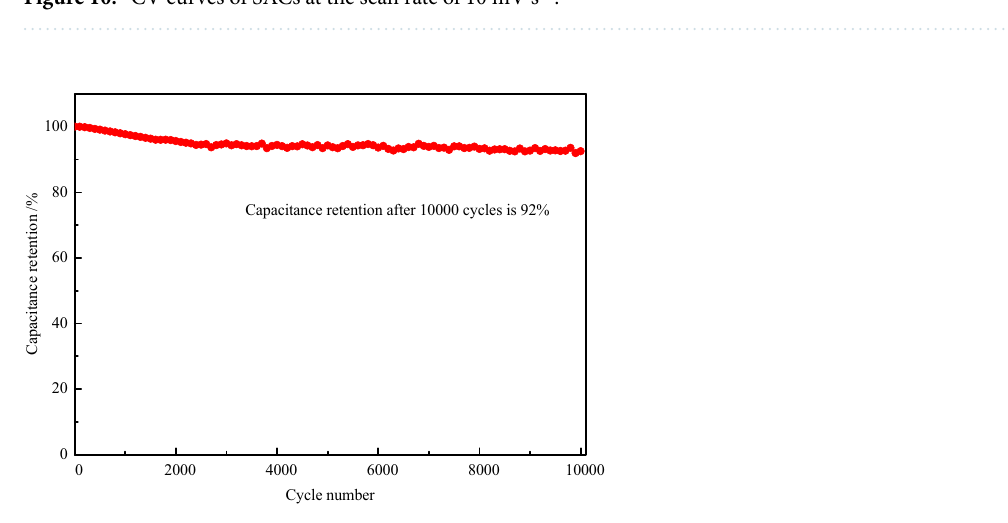
Figure 10. CV curves of SACs at the scan rate of 10 mV s −1 .